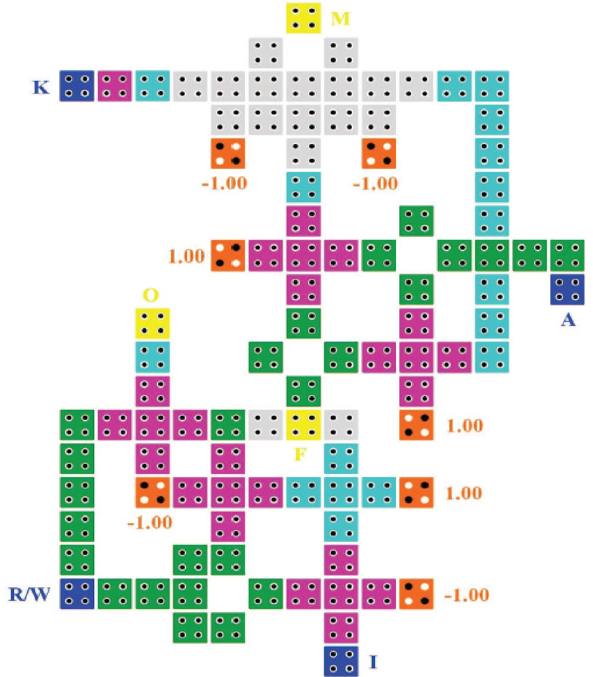
Fig. 8 The developed 1-bit CAM circuit in